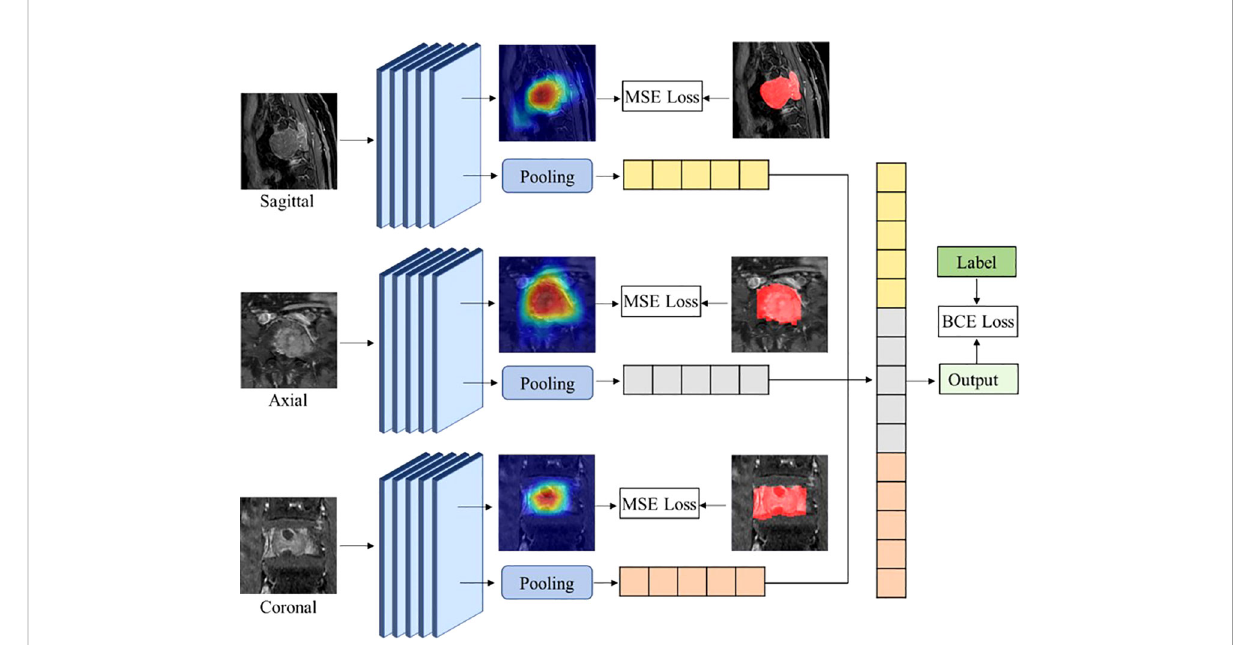
FIGURE 3 The overall framework for the attention-guided multi-view spinal classi fi cation